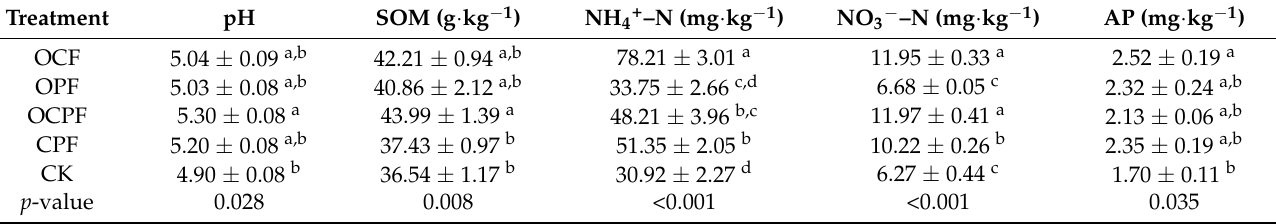
Table 1. Soil chemical properties of different fertilization